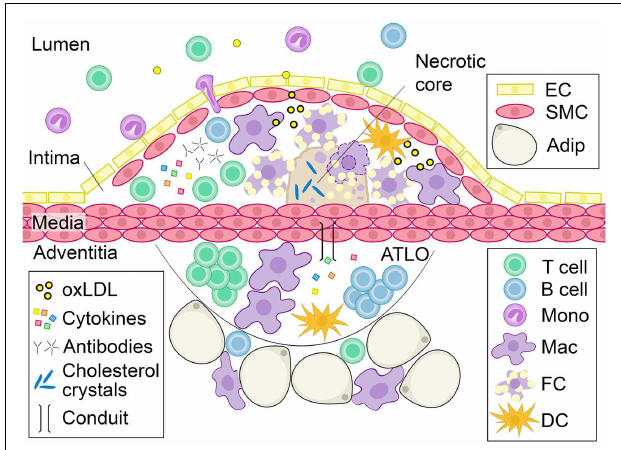
FIGURE 1 | Characteristics of advanced atherosclerotic disease. As luminal LDL is deposited into the subendothelial space of the blood vessel wall, it becomes oxidized. Oxidized lipids trigger the recruitment of leukocytes to the subendothelial space. Monocytes differentiate into dendritic cells or tissue macrophages that take up oxidized lipids and become foam cells.Without effective clearance of these apoptotic-prone cells, they accumulate, secrete pro-inflammatory cytokines and undergo apoptosis and necrosis, dumping their lipid contents into the extracellular space to create a necrotic core. Cytokines and immunoglobulins produced by vessel wall and immune cells can further modulate atherosclerosis. ATLOs are found in the adventitia of diseased vessels and are composed of T cells, B cells, macrophages, and other leukocytes. Soluble factors can cross into the media through conduits and may contribute to plaque development. Abbreviation: oxLDL, oxidized LDL; ATLO, aortic tertiary lymphoid organ; EC, endothelial cell; SMC, smooth muscle cell; Adip, adipocyte; Mono, monocyte; Mac, macrophage; FC, foam cell; DC, dendritic